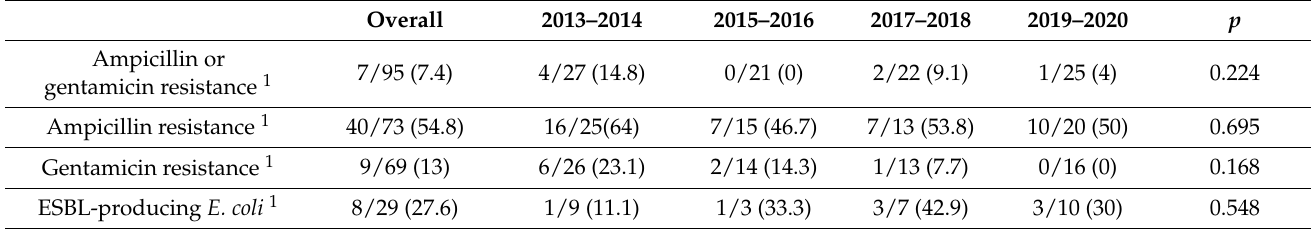
Table 6. The evaluation of antibiotic resistance over 2 year-periods during the study. Overall